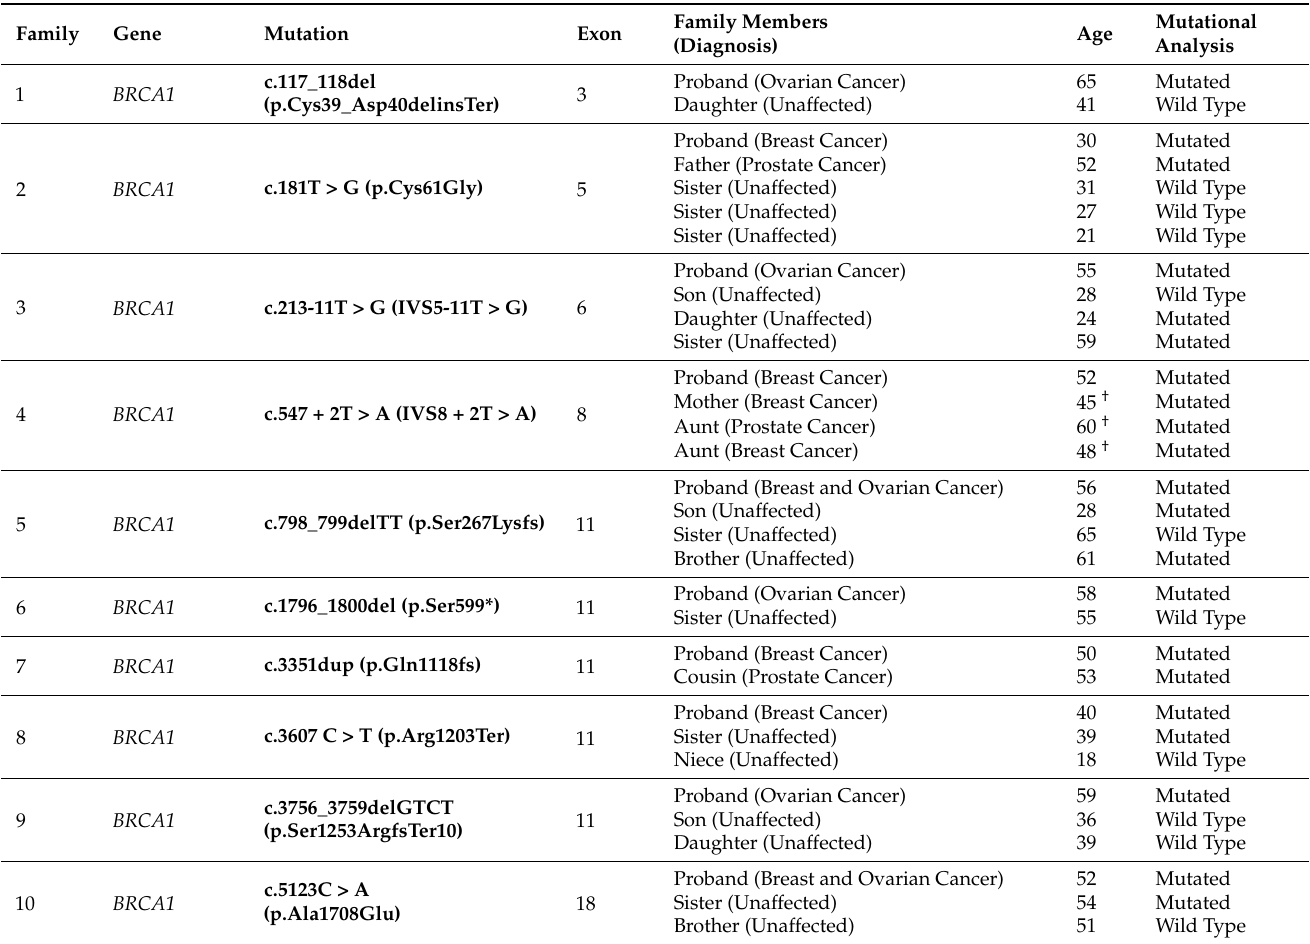
Table 2. Results of mutational analysis conducted in family members of 34HBOC-mutated patients, with all pathogenic variants identified. The names of mutations are reported in